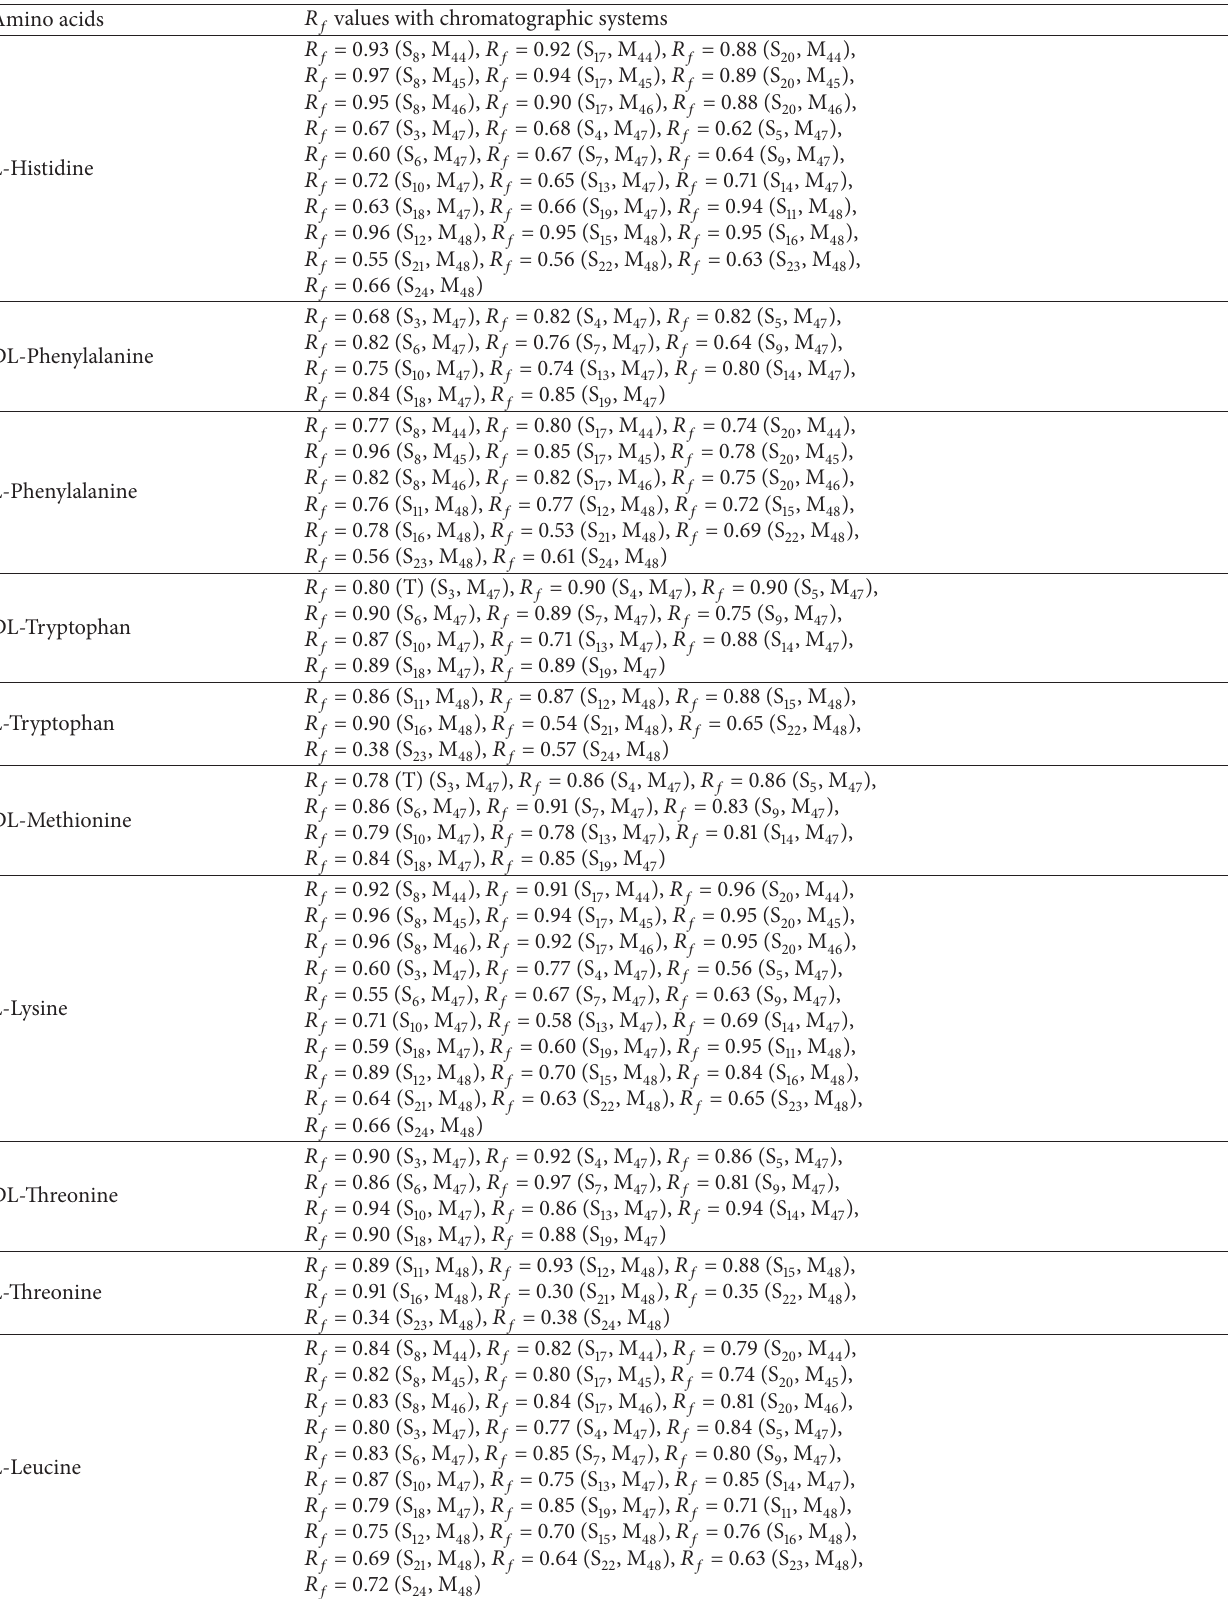
Table 3: 𝑅 𝑓 value of amino acids on different surfactant modified surfaces: data is extracted from references [6–8]. Amino acids 𝑅 𝑓 values with chromatographic systems